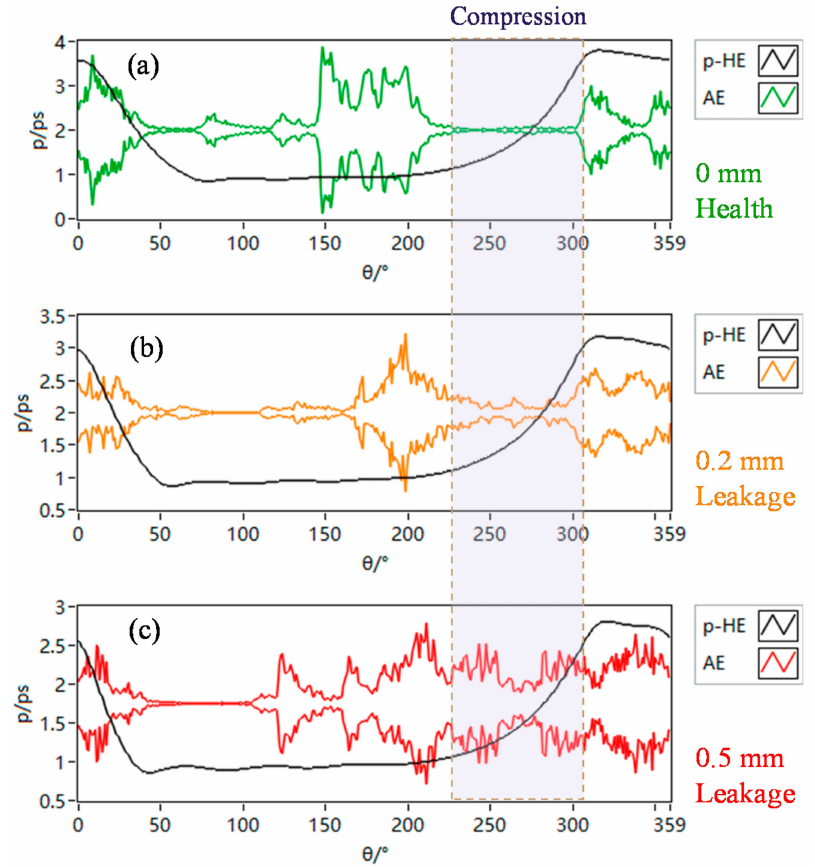
Figure 8. Comparison of p − θ and AE − θ diagrams between health condition ( a ), valve leakage fault